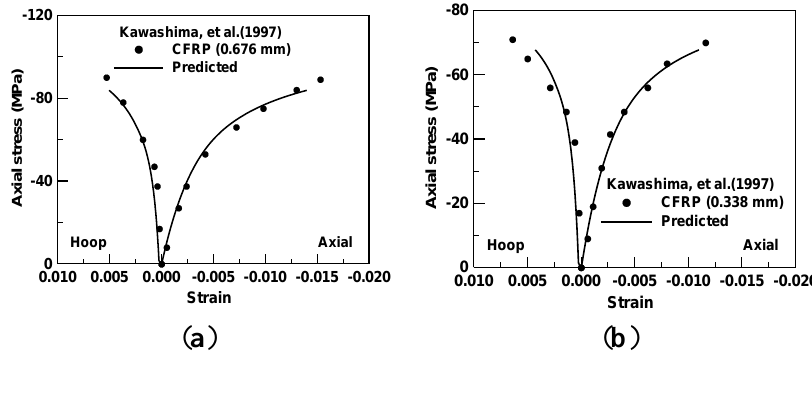
Figure 6. ( a ) Prediction of compression test for CFRP thickness of 0.676 mm; and ( b ) prediction of compression test for CFRP thickness of 0.338